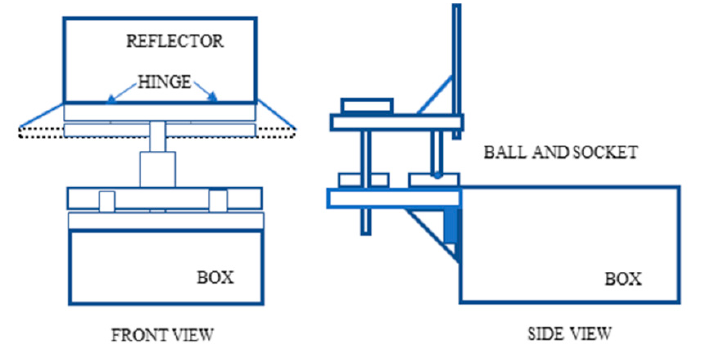
Figure 17. Ball and socket mechanism of right and left side reflectors. Reprinted/adapted with permission from Ref. [53], 2003, Elsevier.